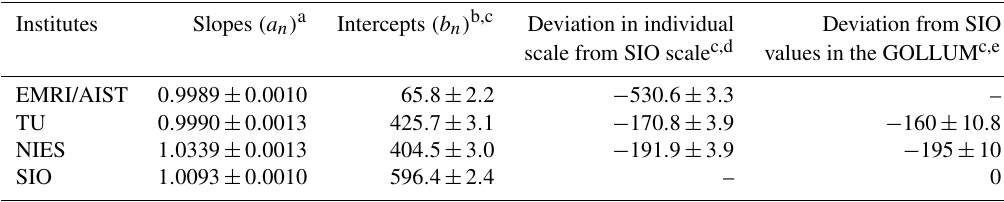
Numbers following the symbol ± denote the standard uncertainty. The uncertainties of slopes and intercepts were calculated based on the Deming least-square fit. a Slope represents the difference in span sensitivity between individual laboratory scales and the NMIJ/AIST scale. b Intercept represents a deviation in individual laboratory scale from the NMIJ/AIST scale corresponding to δ ( O are given in the unit of per meg. d Standard uncertainties were calculated by combining the standard uncertainties of the individual laboratory intercepts. e Figures were provided by Andrew Manning (GOLLUM, 2015; WMO, 2005; Andrew Manning, personal communication, 2021). EMRI/AIST did not participate in the